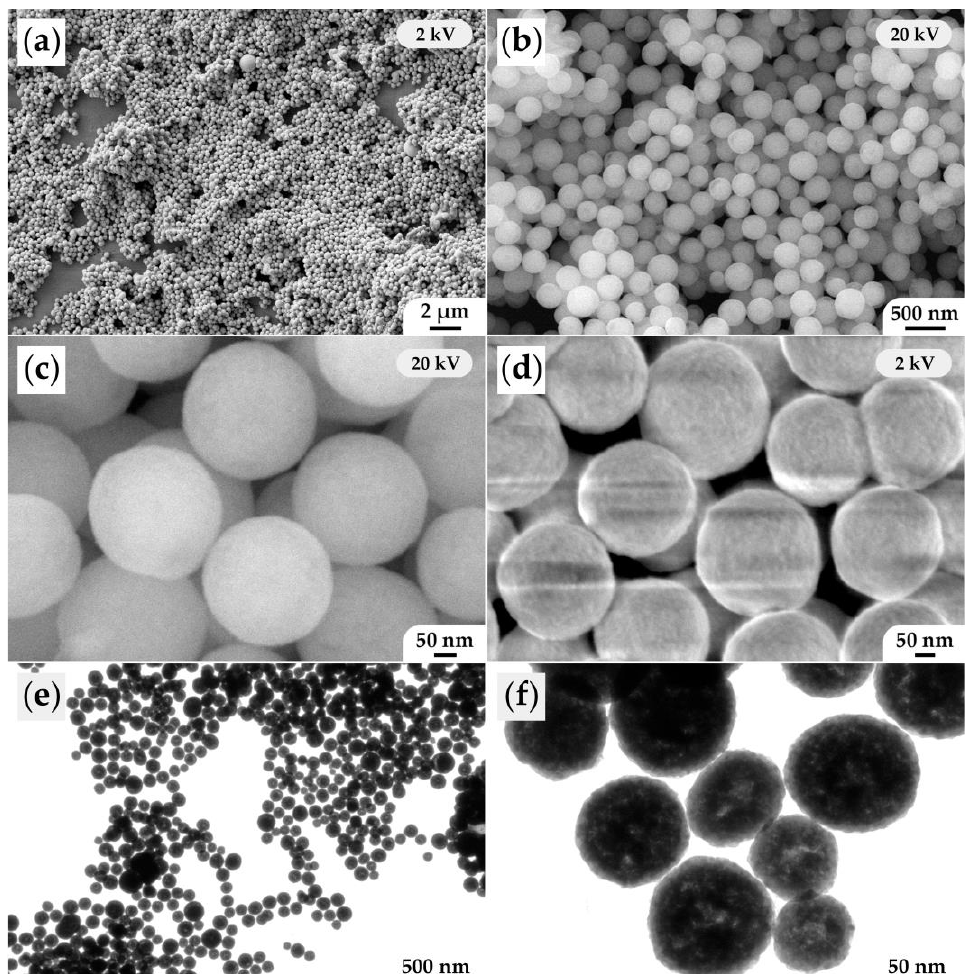
Figure 4. Microstructure of the obtained (CeO 2 ) 0.8 (Sm 2 O 3 ) 0.2 powder according to the SEM ( a – d ) and TEM data ( e , f ).